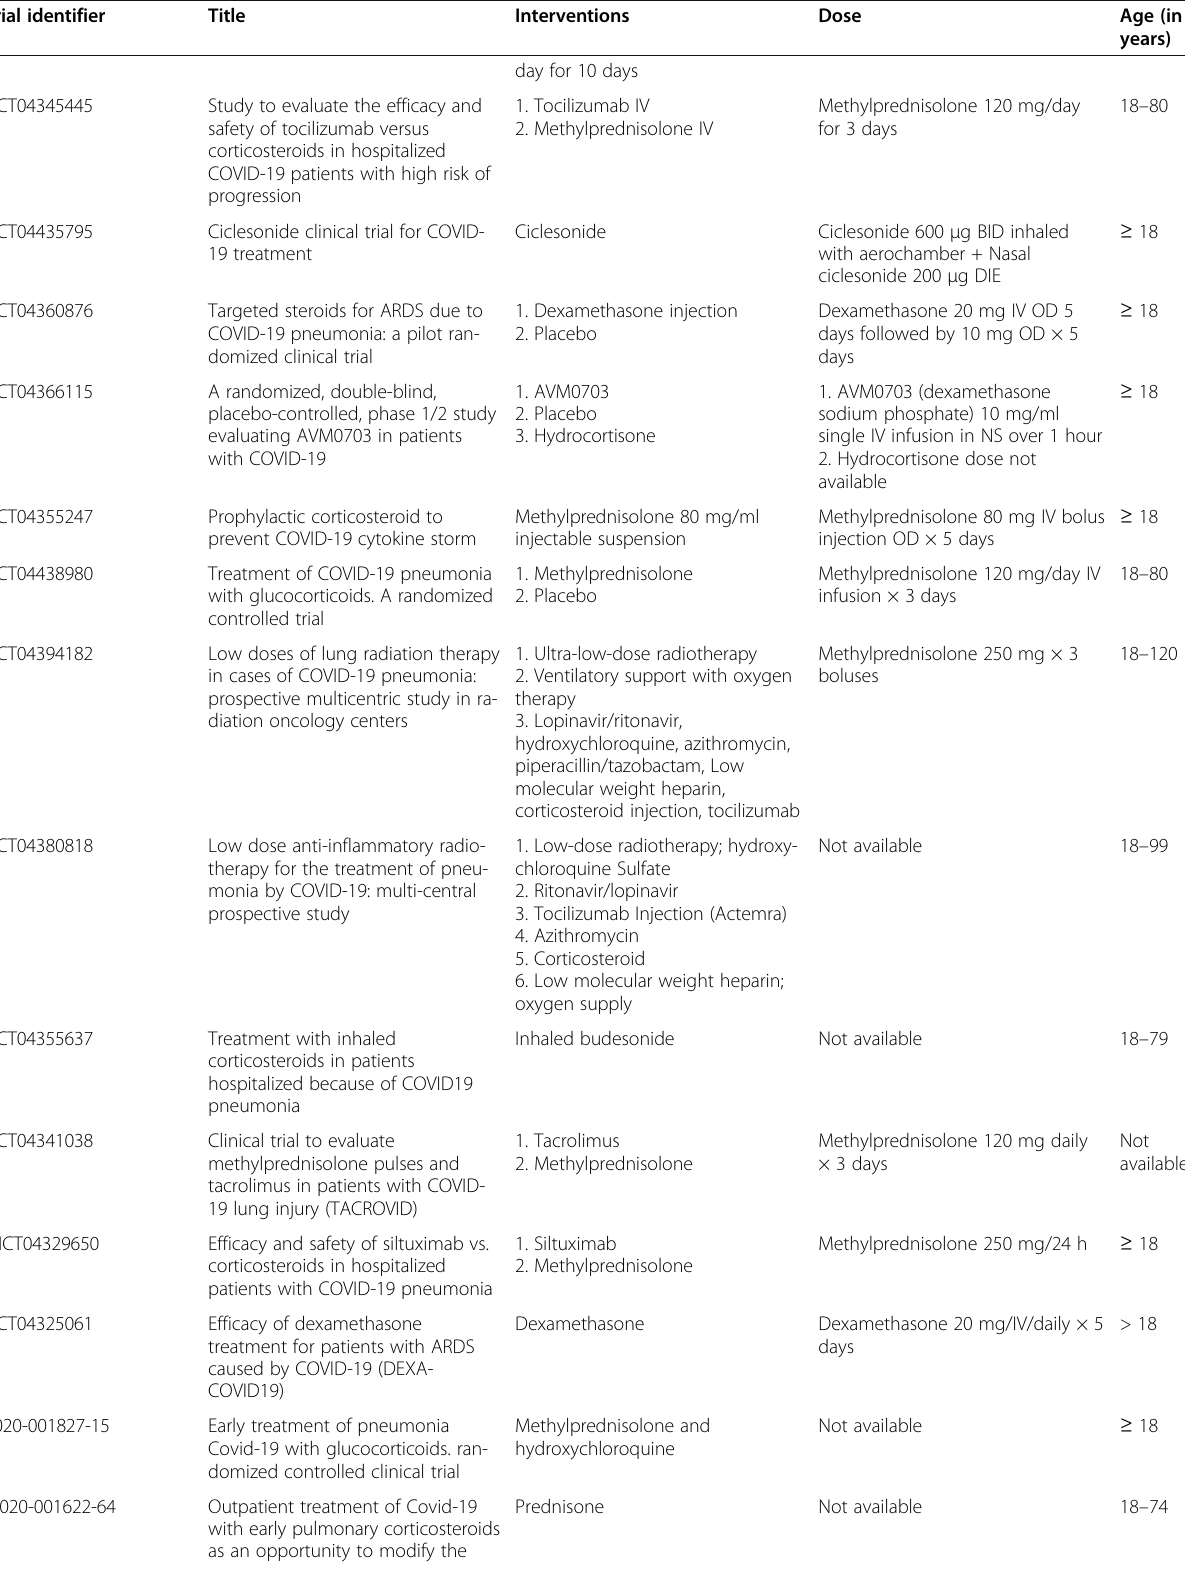
Table 3 Steroid treatment in patients with COVID-19 (Continued) Trial